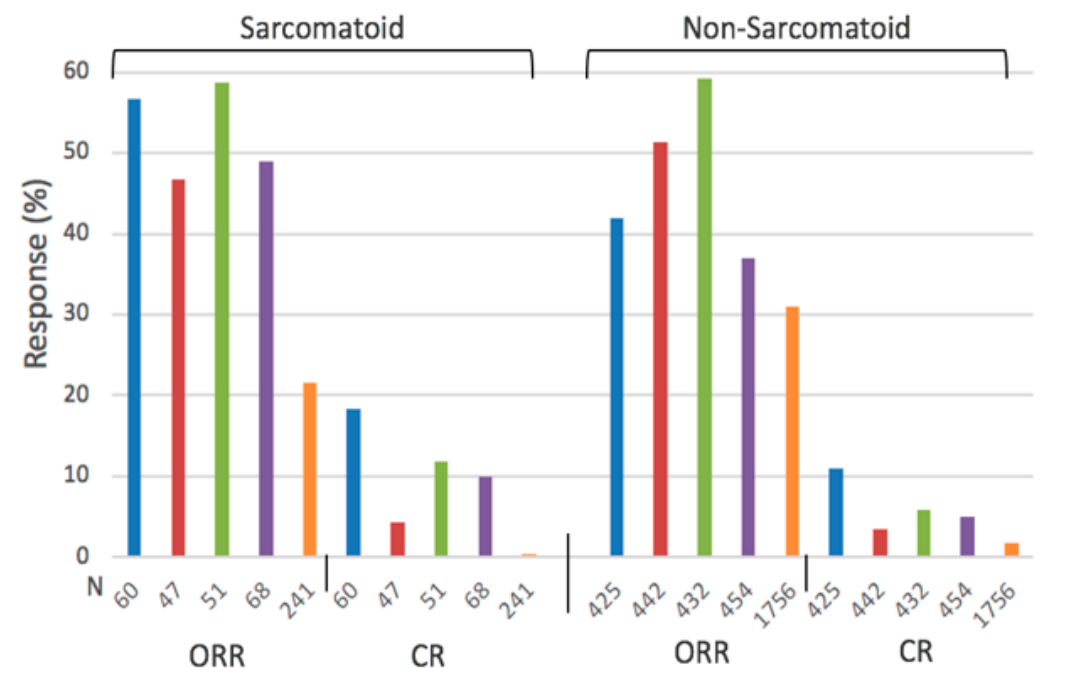
Figure 2. Objective response rate (ORR, (CR + PR)) and complete response (CR) of previously untreated patients with advanced ccRCC with and without sarcomatoid differentiation treated with a combination of biologically targeted molecules: randomized phase 3 clinical trial [1]. The number indicated on the x -axis represents the number of patients included in each clinical trial. Ipilimumab/Nivolumab (blue), Avelumab/axitinib (red), Pembrolizumab/Axitinib (green), Atezolizumab/Bevacizumab (purple), sunitinib (orange).